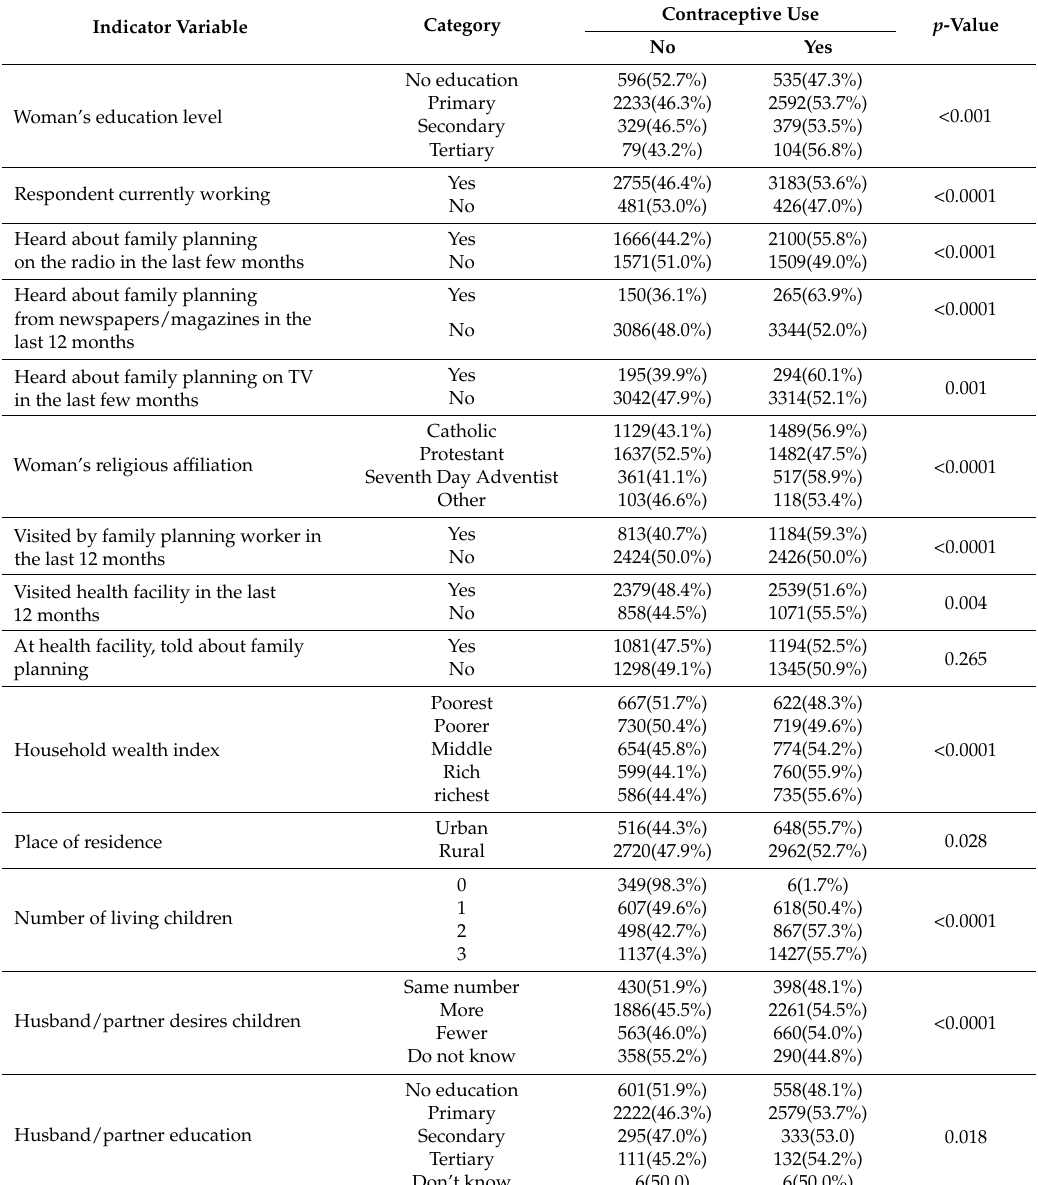
Table 3. The prevalence of contraceptive use among women of childbearing age by category.